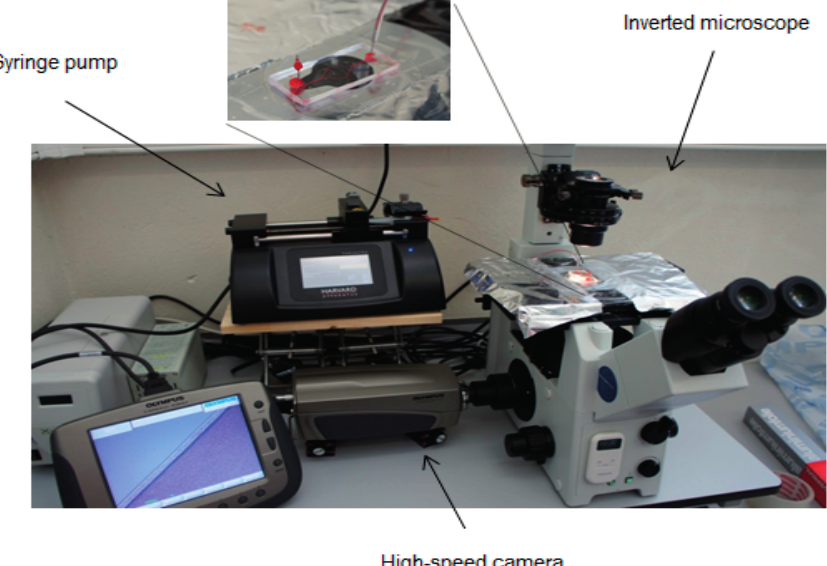
Figure 4. Main experimental equipment used to control and visualize the flow in microchannels produced by xurography.